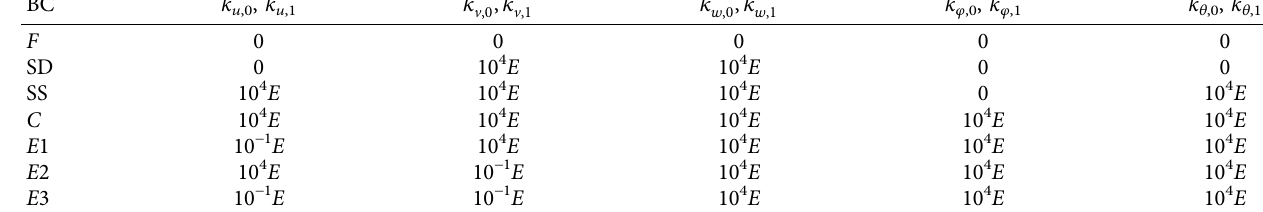
Table 1: Related spring stiffness values.